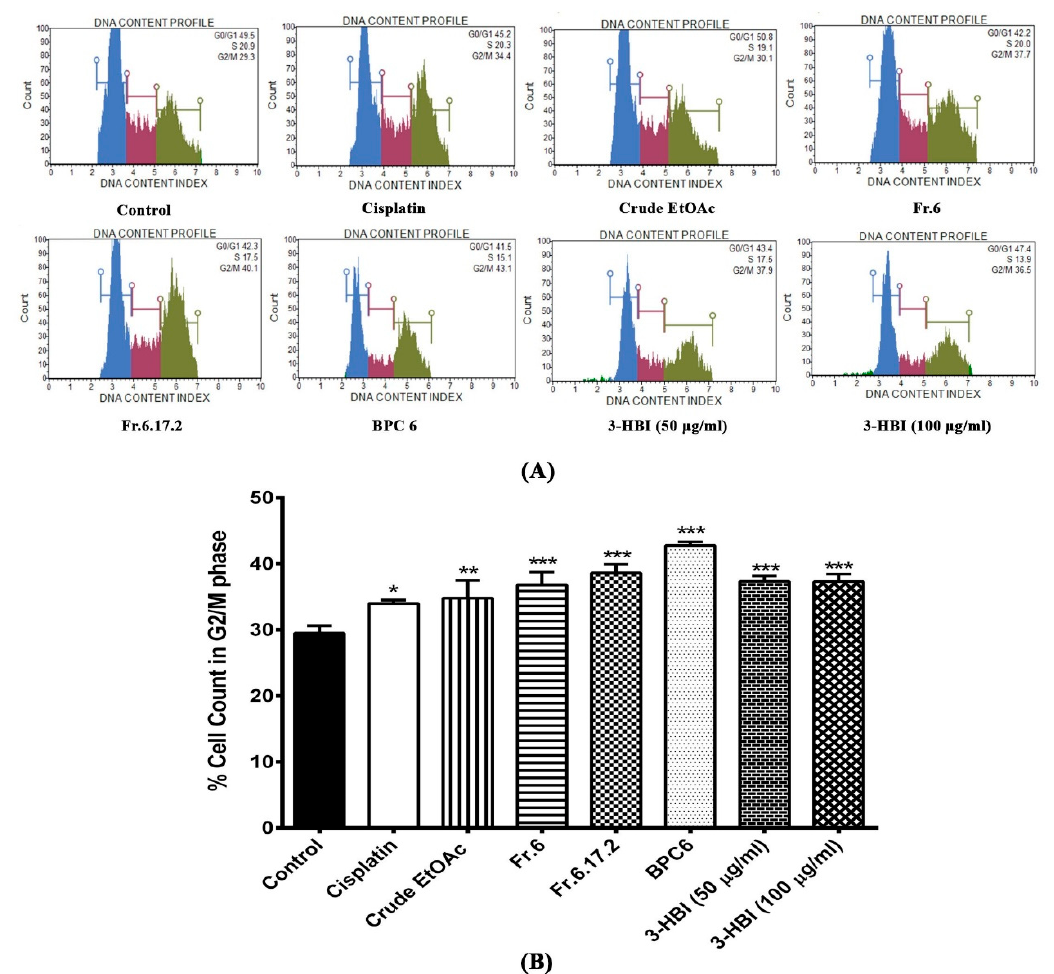
Figure 3. Efficacy of MO extract, fraction no. 6, sub-fraction no. 6.17.2, BPC6, and 3-HBI on distribution of SCC15 in the cell cycle analysed by Muse ™ Cell Analyser. ( A ) DNA content index histogram of cell populations in each phase of the cell cycle in SCC15 cell line after treatment with cisplatin, crude EtOAc, Fr.6, Fr.6.17.2, BPC6, and 3-HBI for 24 h. ( B ) Bar graphs of percentage of cell in G2 / M phase for SCC15 cell line. Data are presented as means ± SEM. * p ≤ 0.05, ** p ≤ 0.01, and *** p ≤ 0.001 compared to control. Control: untreated SCC15; crude EtOAc: crude ethyl acetate; Fr.6: fraction no. 6; Fr.6.17.2: sub-fraction no. 6.17.2; BPC6: base peak chromatogram no. 6; 3-HBI: 3-hydroxy- β -ionone.